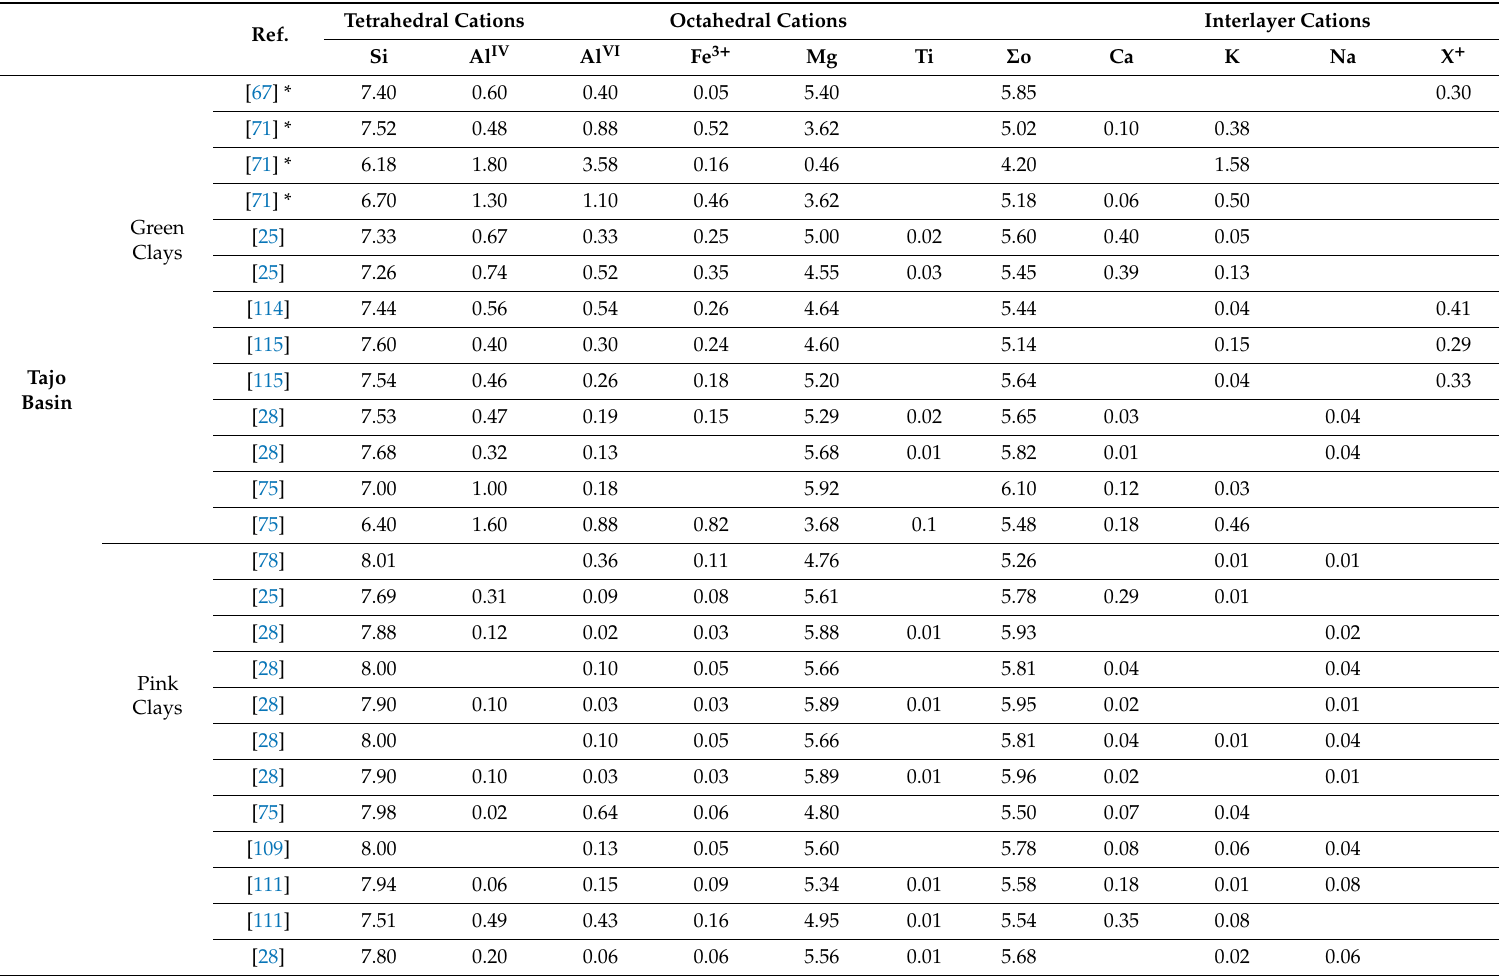
Table 4. Structural formulae of Spanish bentonites taken from previous works. REF: number of references. X + : interlayer charge. Analyses with “*” were done by AEM, and analyses without “*” were done from whole